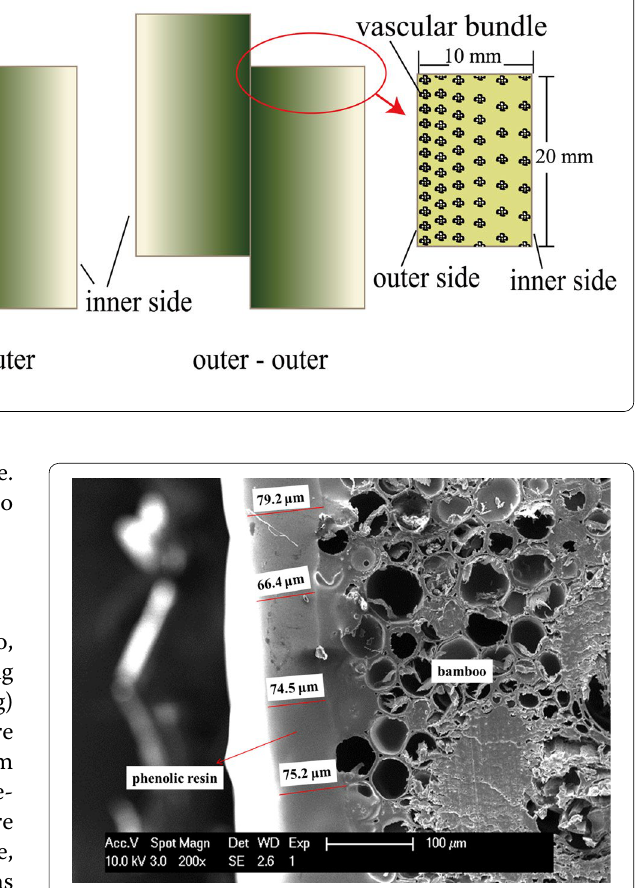
Fig. 2 Morphology of bamboo strips sample with phenolic